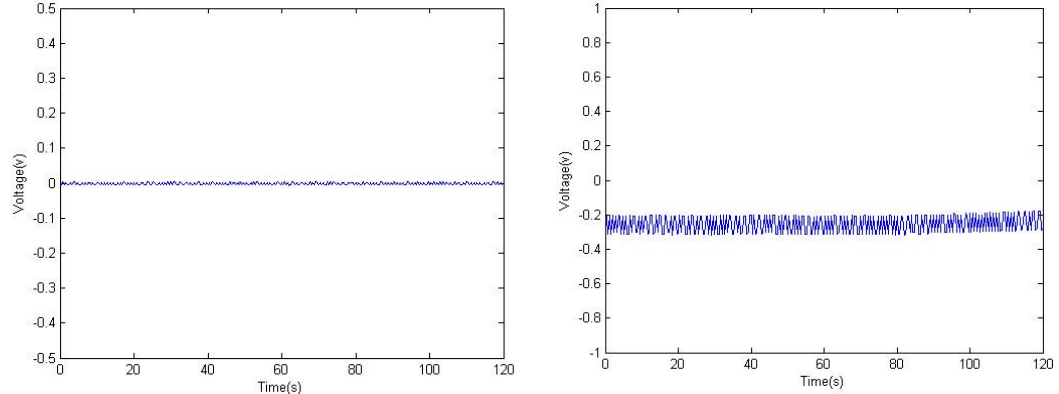
Figure 10. Voltage output at point 1 ( left ); and point V 1 ( right ).